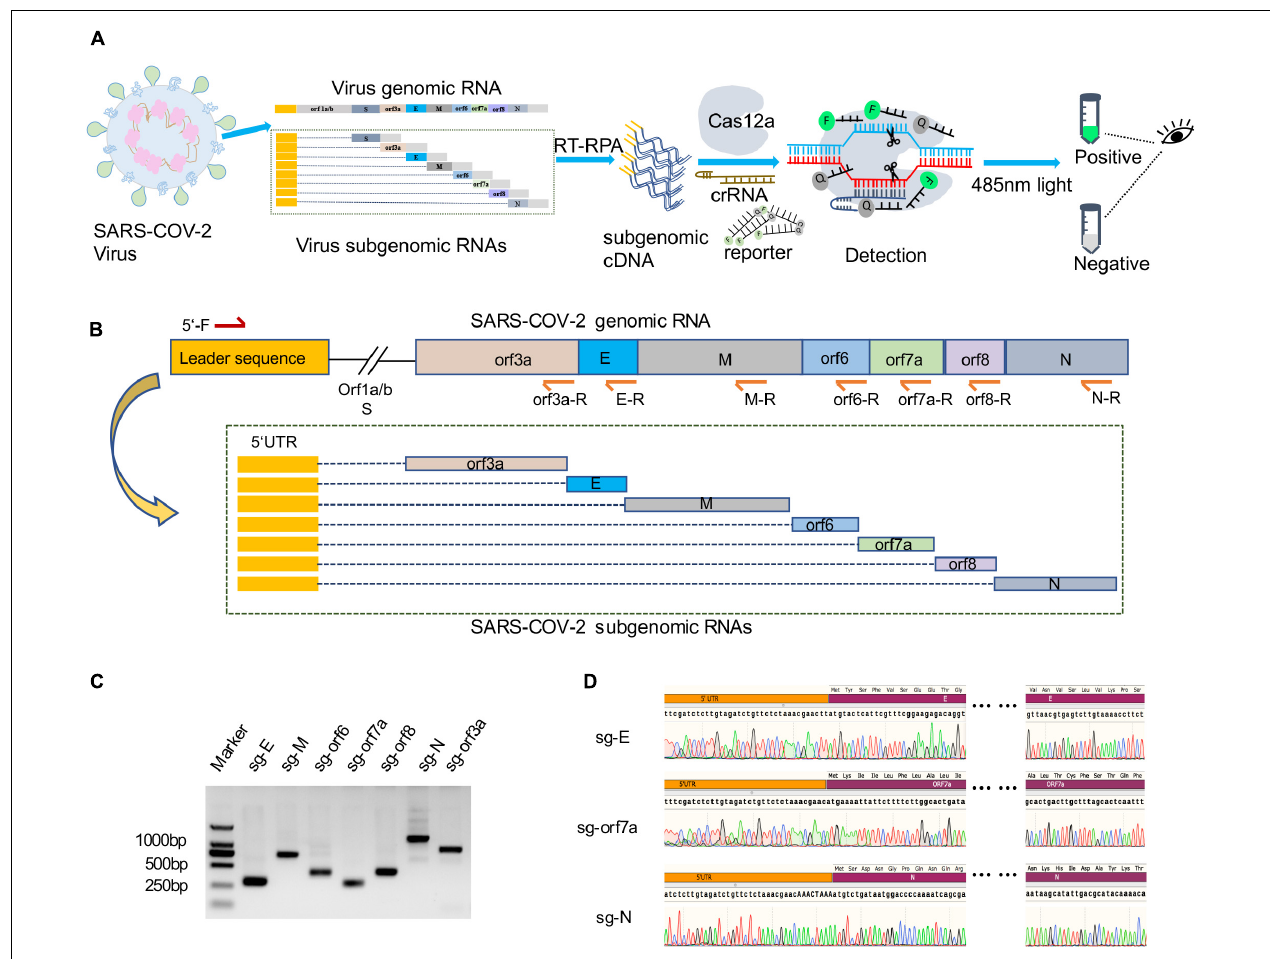
FIGURE 1 | Amplification and verification of SARS-CoV-2 subgenome in a diagnosed clinical sample. (A) Schematic illustration of CRISPR/Cas12a based detection of active SARS-CoV-2 (CRISPR-actCoV). Subgenomic RNA was specifically amplified by RT-RPA and then subjected to CRISPR/Cas12a mediated fluorescence reporter assay, and the results can be read by naked eyes under 485nm light. (B) Schematic diagram of SARS-CoV-2 subgenomic RNAs (sgRNAs) and the location of primers used for sgRNAs amplification. The forward primer (5 (cid:48) -F) was designed to target a common 5 (cid:48) leader sequence, the reverse primers (orf3a-R, E-R, M-R, orf6-R, orf7a-R, orf8-R, N-R) were designed to target each gene body. (C) Image of DNA agarose gel electrophoresis of amplified nucleic acid fragments containing SARS-CoV-2 sgRNA sequence. Marker, DL2000 DNA marker. sg-E, sg-M, sg-orf6, sg-orf7a, sg-orf8, sg-N, sg-orf3a, the nucleic acid fragments containing